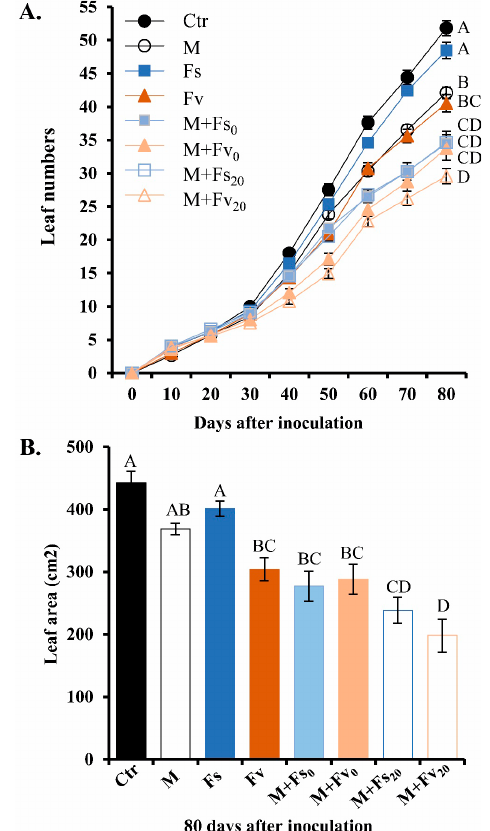
Fig. 5: Leaf number and leaf area index (cm 2 ) of inka nut plants during the presence of Meloidogyne incognita and Fusarium spp. A) Leaf number of inka nut plants under different treatments measured bet- ween intervals of 10-days until three months; B) Leaf area of inka nut plants after 80-days of treatment. Error bars indicate standard deviation (± S.D.). Columns with the same letter are not significantly different ( p <0.05).